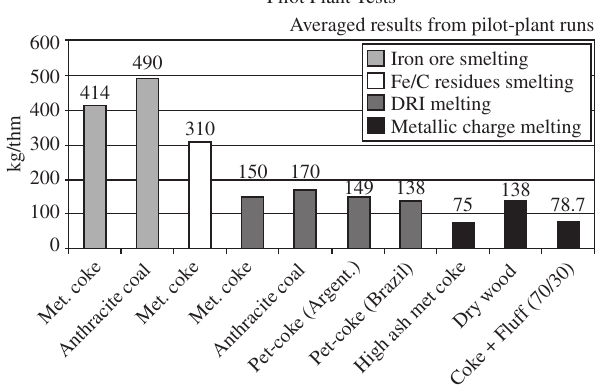
size range of the iron and carbon bearing materials, moisture, etc.